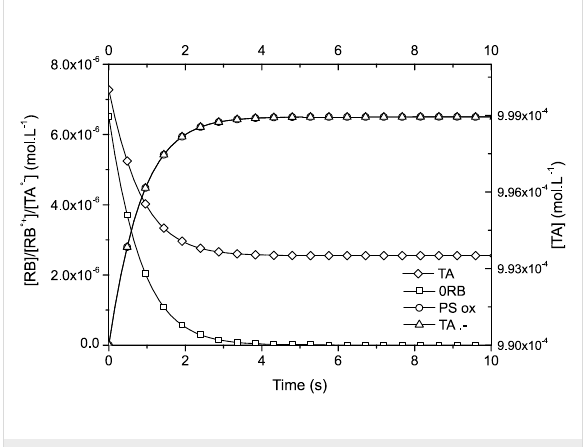
Figure 4: Evolution of RB, RB •+ , TA, and TA • − concentration with time for RB/TA system.